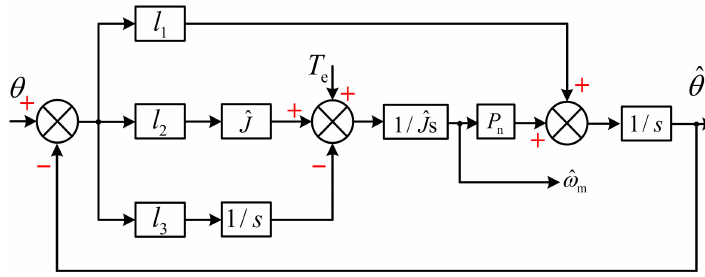
Figure 4. Block diagram of Luenberger